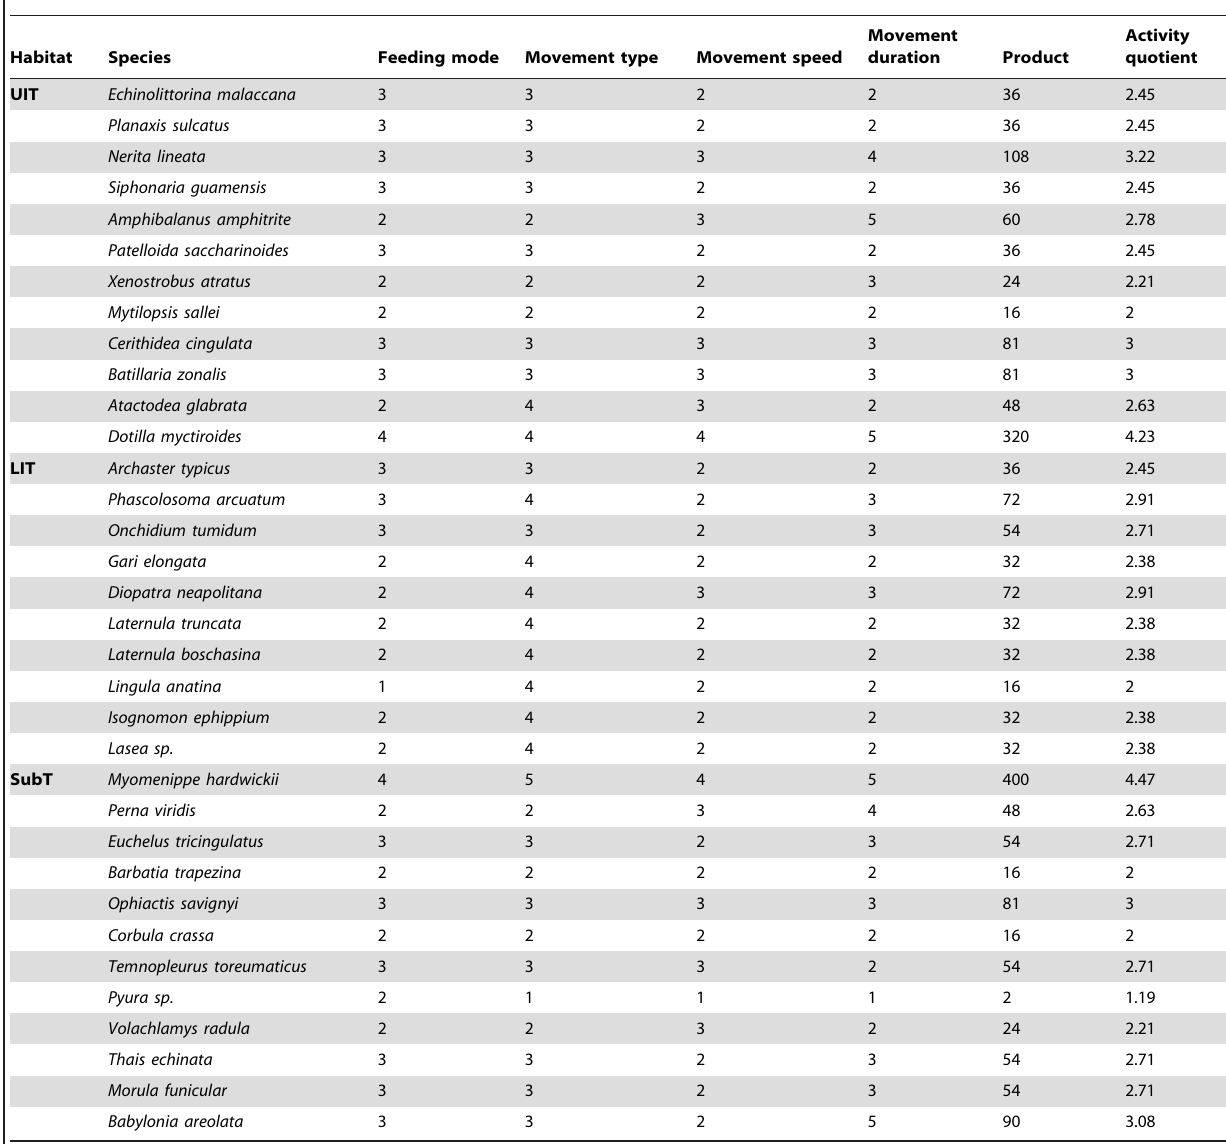
Table 1. Scores for feeding mode, movement type, speed and duration during day for each species.